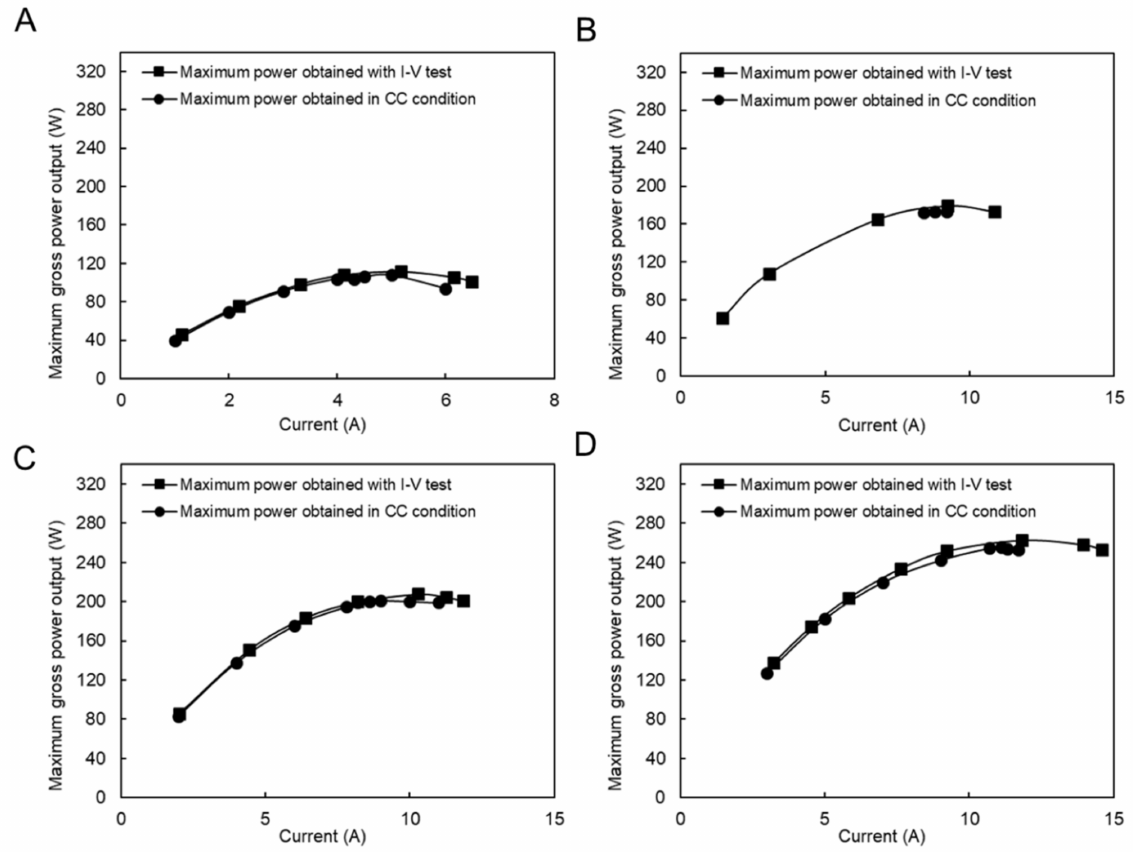
Figure 8. Constant current and I–V measurement with the model RO brine and RW feed solution, ( A ) RO brine/RW; 2/14 (L/min), ( B ) RO brine/RW; 8/13 (L/min), ( C ) RO brine/RW; 7/20 (L/min), ( D ) RO brine/RW; 22/31